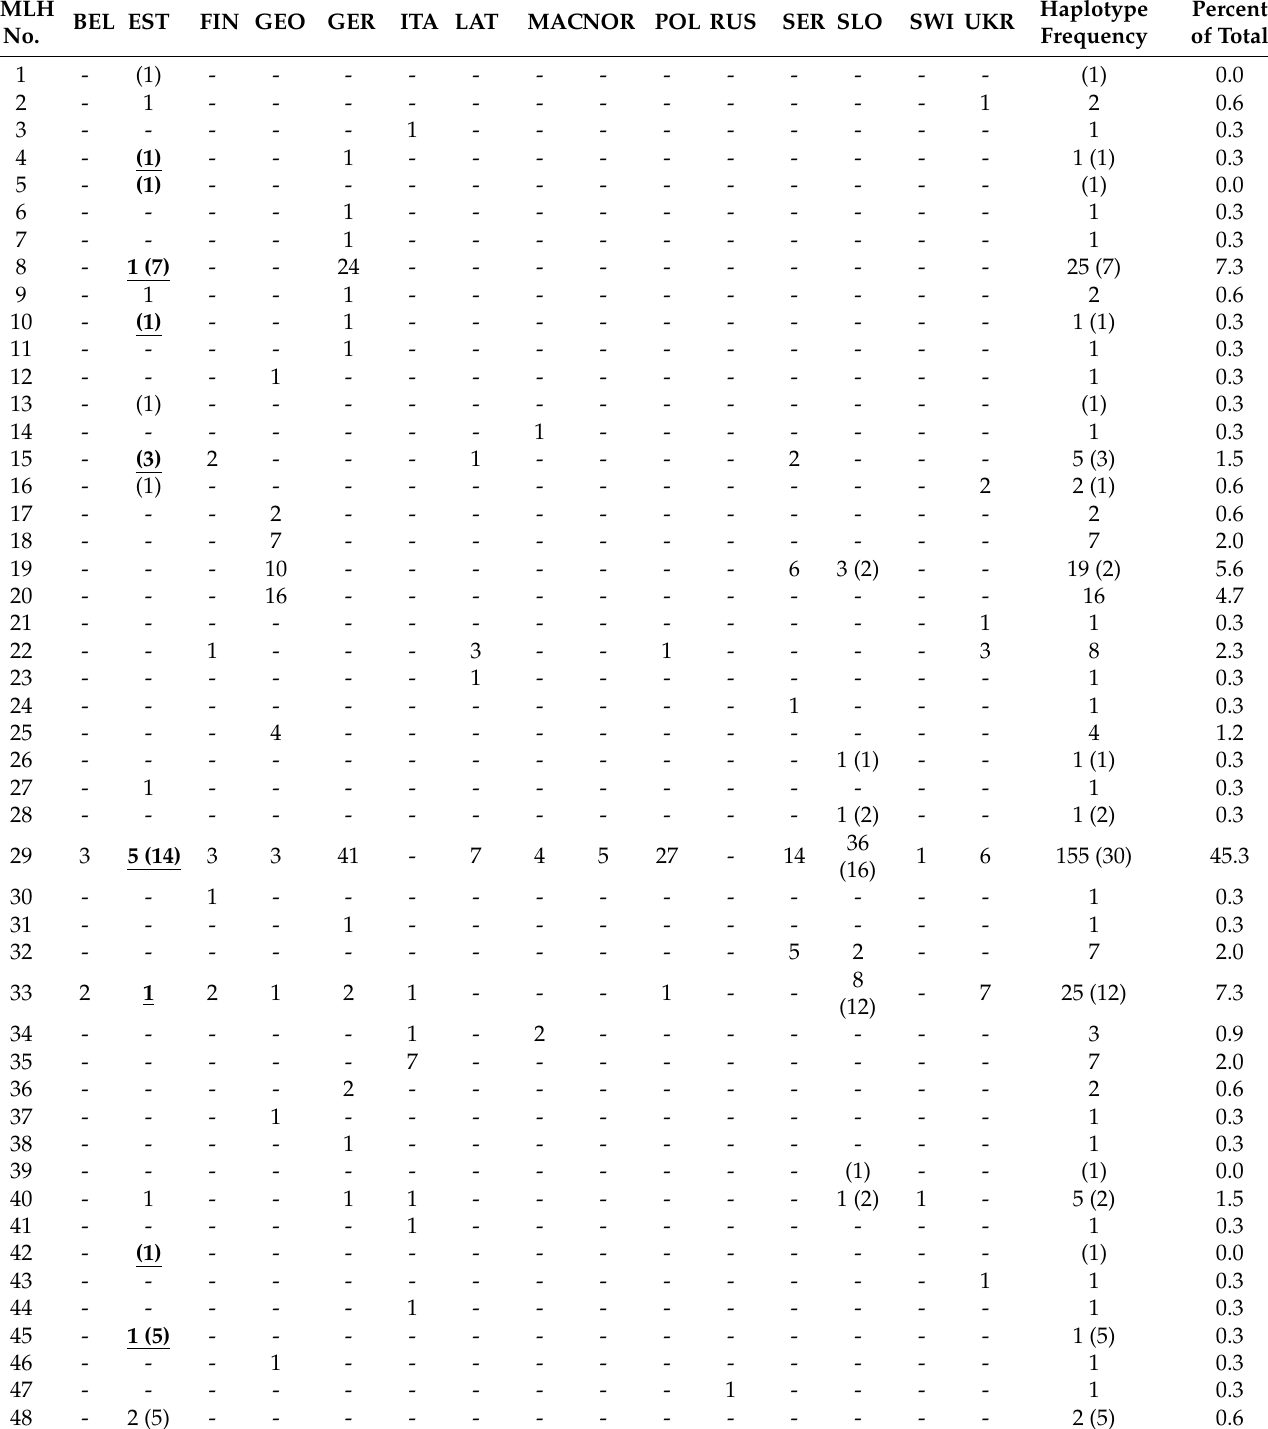
Table 2. Haplotype frequencies of D. sapinea in Europe. Occurrence of 52 multilocus haplotypes (MLHs) (based on 13 microsatellite markers) among isolates of D. sapinea isolated in 14 European countries and